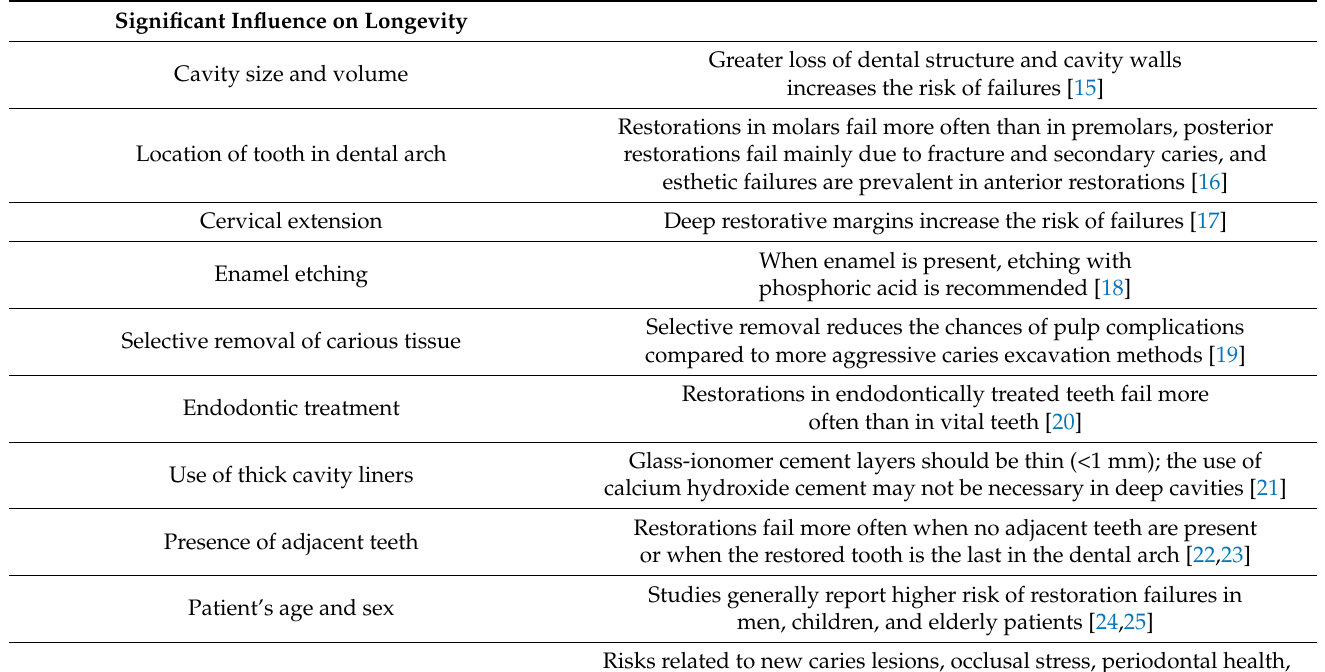
Table 1. Factors that have significant or limited influences on the clinical longevity of direct resin composite